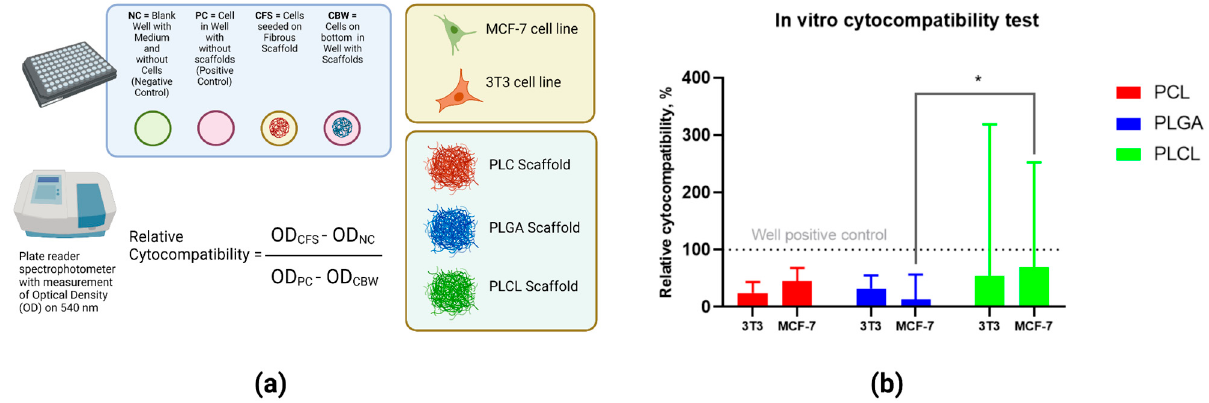
Figure 6. ( a ) Technique for the assessment of cytocompatibility of polymeric materials by seeding with MCF-7 and 3T3 cells, results presented on day 7; ( b ) Results of the MTT assay of PCL, PLGA, and PLCL. *— p -value <